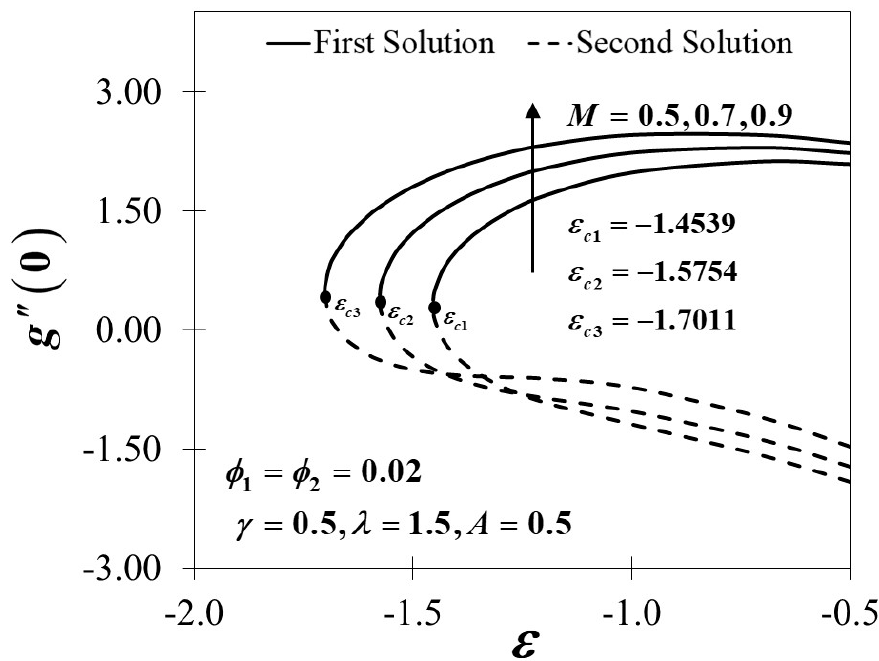
Figure 11. Variations of g (cid:48)(cid:48) ( 0 ) for di ff erent values of M .